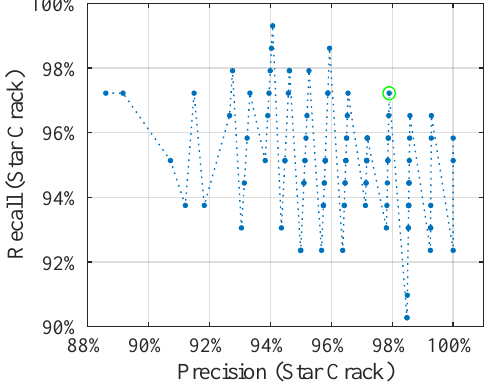
Figure 8. CNNs: Recall vs. precision of the class star